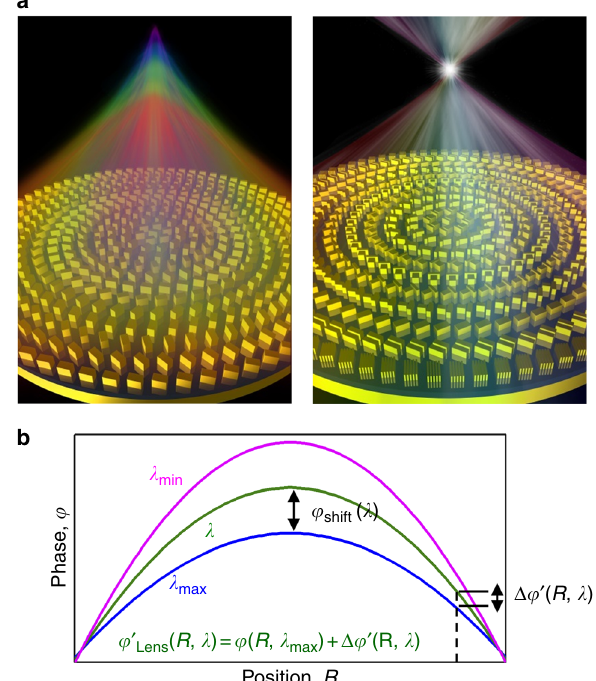
Fig. 1 Achromatic metalens. a Schematic for chromatic ( left ) and achromatic ( right ) metalenses. In the case of chromatic metalens, the focal length is changed as the incident wavelength is switched, resulting in a rainbow-like focal line when it is illuminated by a light source with continuously changed wavelength. The focal point will become a single spot for the case of BAML with optimized phase compensation. b Phase pro fi le for a BAML at arbitrary wavelength of λ ∈ { λ min , λ max